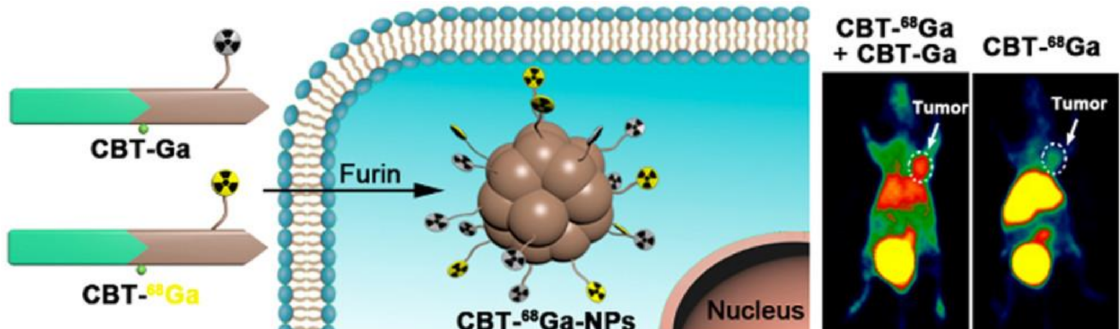
Figure 1. Schematic illustrations of furin-controlled condensation of CBT- 68 Ga and CBT-Ga to yield hybrid oligomers that self-assemble into radioactive nanoparticles CBT- 68 Ga-NPs in furin- overexpressing cancer cells and representative whole-body coronal microPET images of MDA-MB- 468 tumor-bearing mice at 1 h post-intravenous injections of 100 µ L of 5–12 MBq CBT- 68 Ga and 20 mg/kg CBT-Ga (left) or 5–12 MBq CBT- 68 Ga (right) via tail veins. Reprinted with permission from ref. [23], Copyright 2019 American Chemical